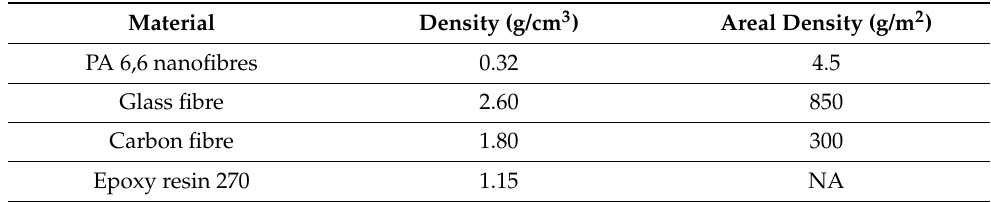
Table 1. Material Characterisation.